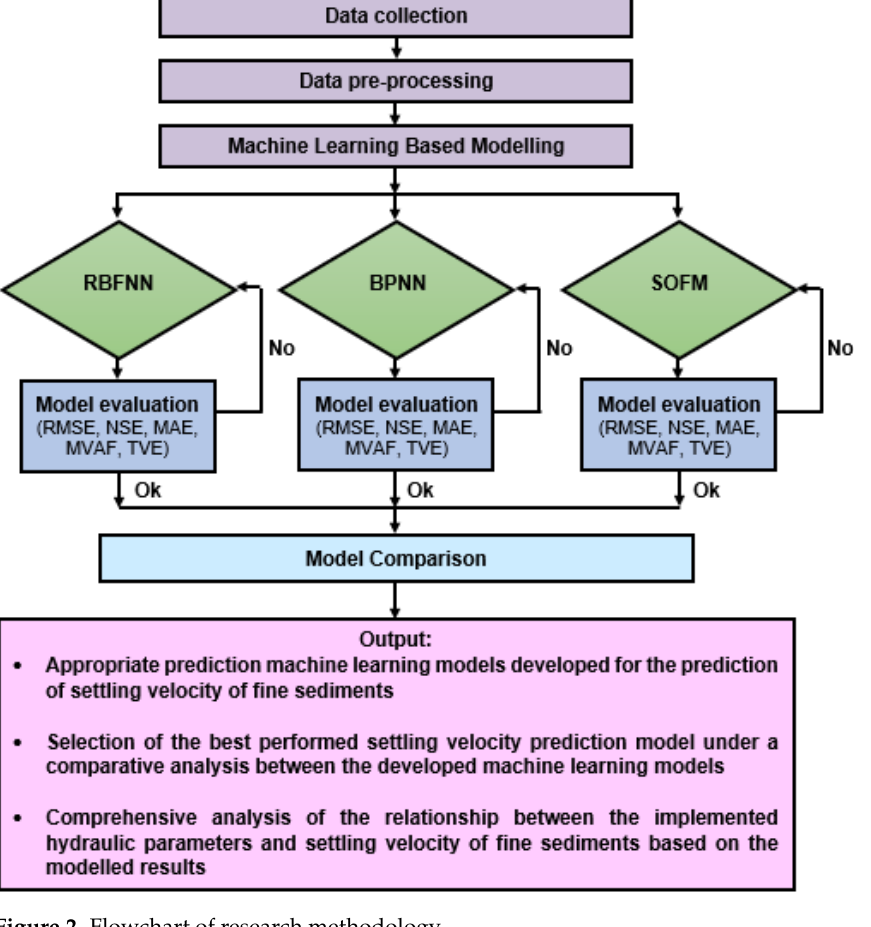
Figure 2. Flowchart of research methodology.